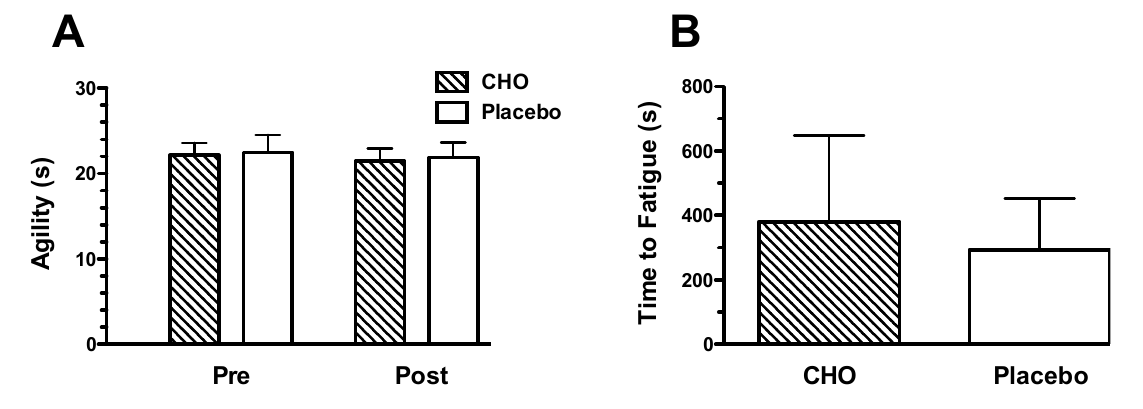
Figure 3. Changes in agility ( A ) and the time to fatigue ( B ) during the simulated soccer match while drinking the placebo (0% CHO) and 7% CHO